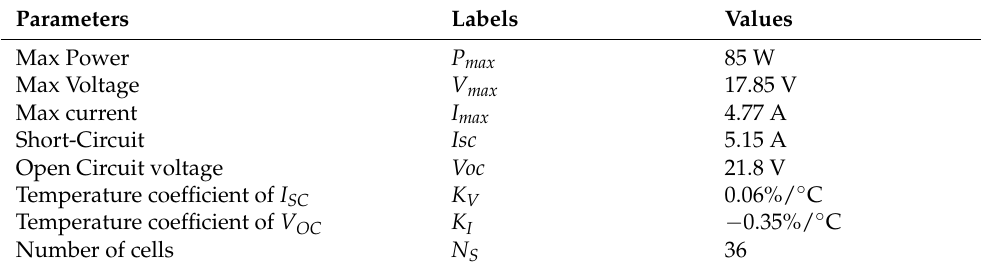
Table 3. Characteristics of the DM-85 PV panel at standard test conditions (STC).